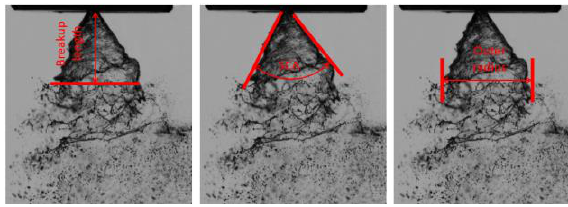
Fig. 3. High speed visualization for air flow of 16 m/s .